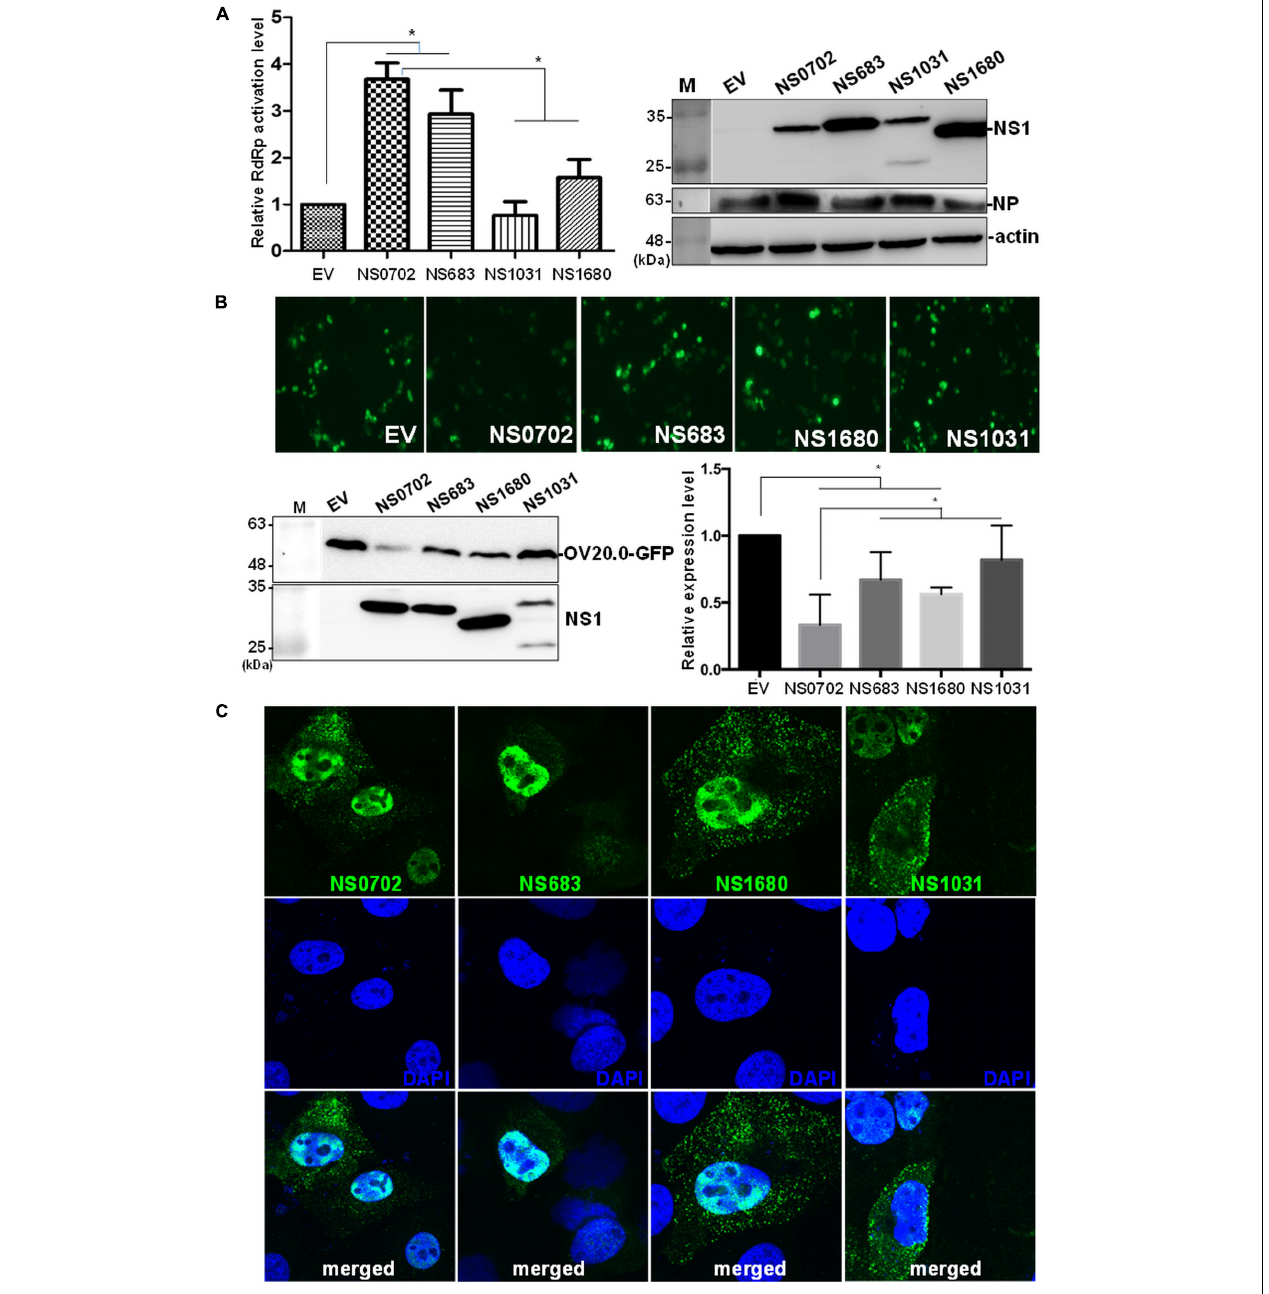
FIGURE 8 | Impact of non-structural (NS) on viral genome activity. (A) Evaluation of the effect of non-structural protein 1 (NS1) on RNA-dependent RNA polymerase (RdRp) activity by mini-genome reporter assay. HEK293T cells were transfected with constructs expressing the viral RdRp complex (PA, PB1, PB2) and NP proteins, as well as a reporter plasmid pPol I-Flu-Rluc and internal control plasmid expressing firefly luciferase. At 24 h post transfection, luciferase activity and the expression of NS1 and NP of whole-cell lysate were monitored by luciferase assay and Western blot analysis, respectively. The Renilla luciferase expression level was initially normalized with firefly luciferase in the same group, and then the relative expression level was obtained by comparison with EV transfection, which was arbitrarily set as 1. The experiment was conducted in triplicate. *Indicates p -value < 0.05. (B) Effect of NS1 on expression of a heterogeneous gene in cells. The individual NS1 was transiently co-expressed with a green fluorescent protein (GFP) fusion protein in HEK293T cells. Overall GFP signal was recorded by fluorescent microscopy (the top panel) and Western blot analysis (bottom, left panel); and the expression level, relative to that without NS1 protein, was measured and plotted (bottom, right panel). (C) Localization of ribonucleoprotein (RNP). Madin–Darby canine kidney (MDCK) cells were infected by individual avian influenza viruses engineered by reverse genetics (RG-AIVs) at a multiplicity of infection (MOI) of 1 for 24 h followed by immunofluorescent assay using antibodies against NP protein and DAPI to indicate the localization of RNP and the nucleus, respectively. The images were taken under confocal microscopy (400 × magnification).